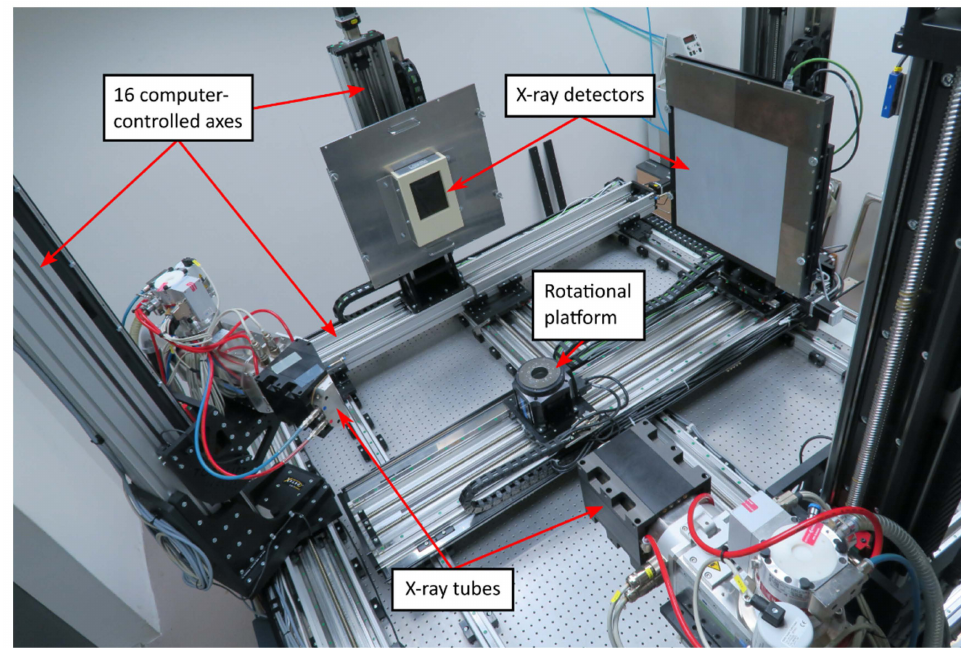
Figure 2. TORATOM scanner.